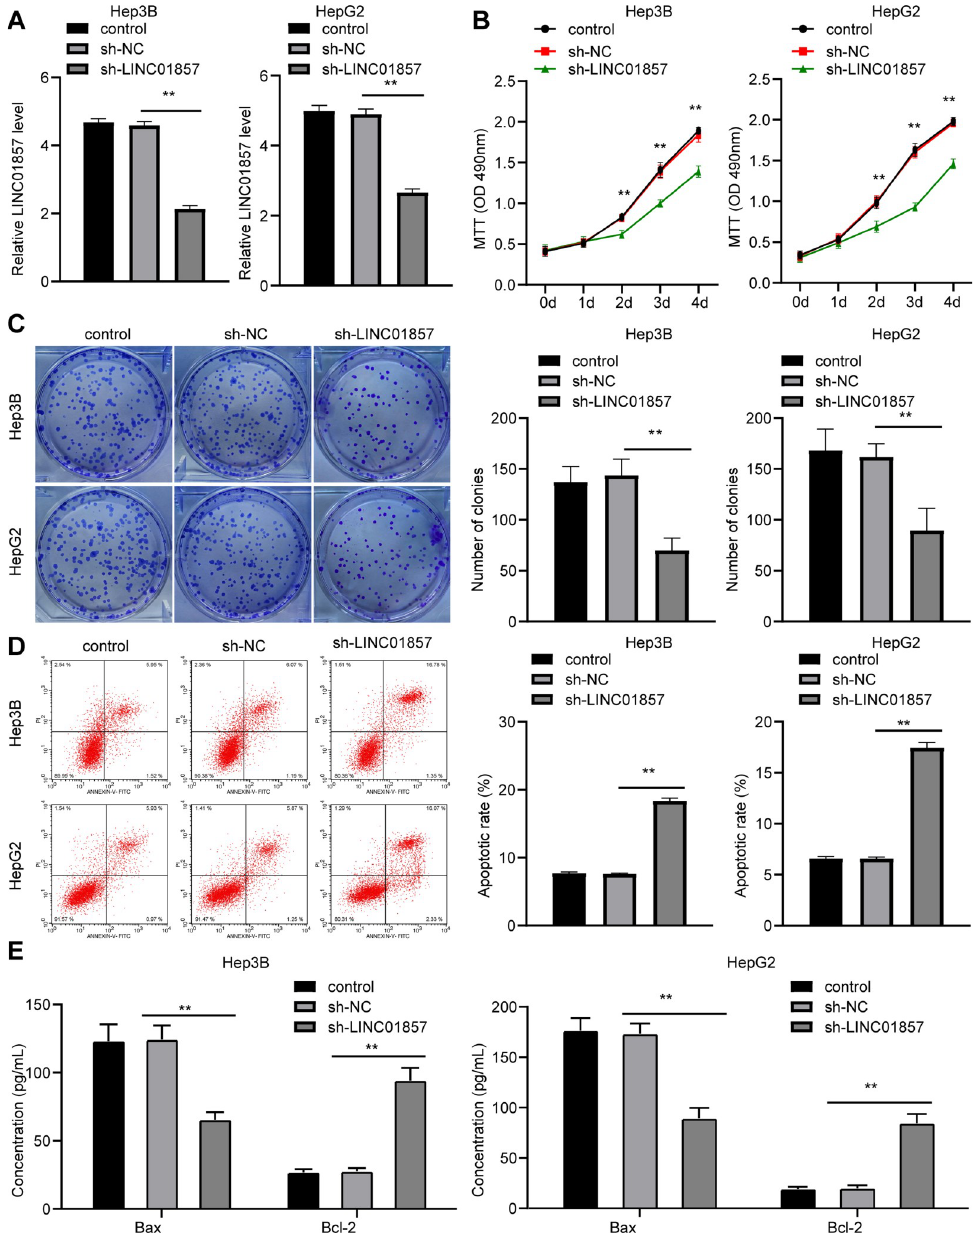
Fig 2. LINC01857 inhibition inhibits HCC cell proliferation and promotes apoptosis. HCC cells were infected with sh-LINC01857, with sh-NC as NC. A, LINC01857 expression in HCC cells verified by RT-qPCR. B and C, HCC cell proliferation detected by MTT (B) and colony formation assay (C). D, apoptotic rate assessed by flow cytometry. E, levels of Bax and Bcl-2 in HCC cells measured via ELISA. Three independent repeated tests were conducted. The results were presented as mean ± standard deviation. One-way ANOVA was employed to analyze the data in panels A, C and D. Two- way ANOVA was employed to analyze the data in panels B and E. Tukey’s multiple comparisons test was applied for the post hoc test. �� p <